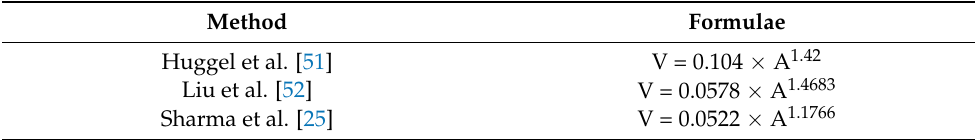
Table 2. Formulae used for lake volume estimation applying in Emmer and Vil í mek [54] methodology.